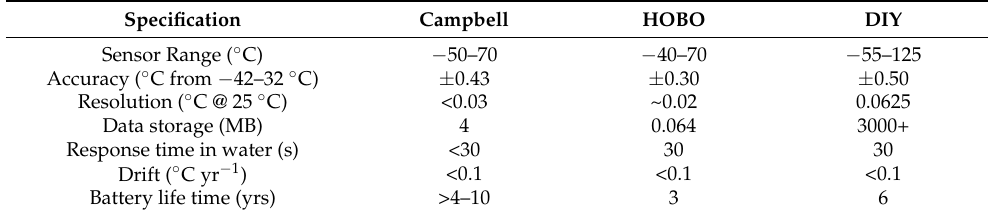
Table 1. Technical specification of three soil temperature data logger systems including our DIY soil temperature data logger based upon the manufacturer’s datasheets for the equipment or components.